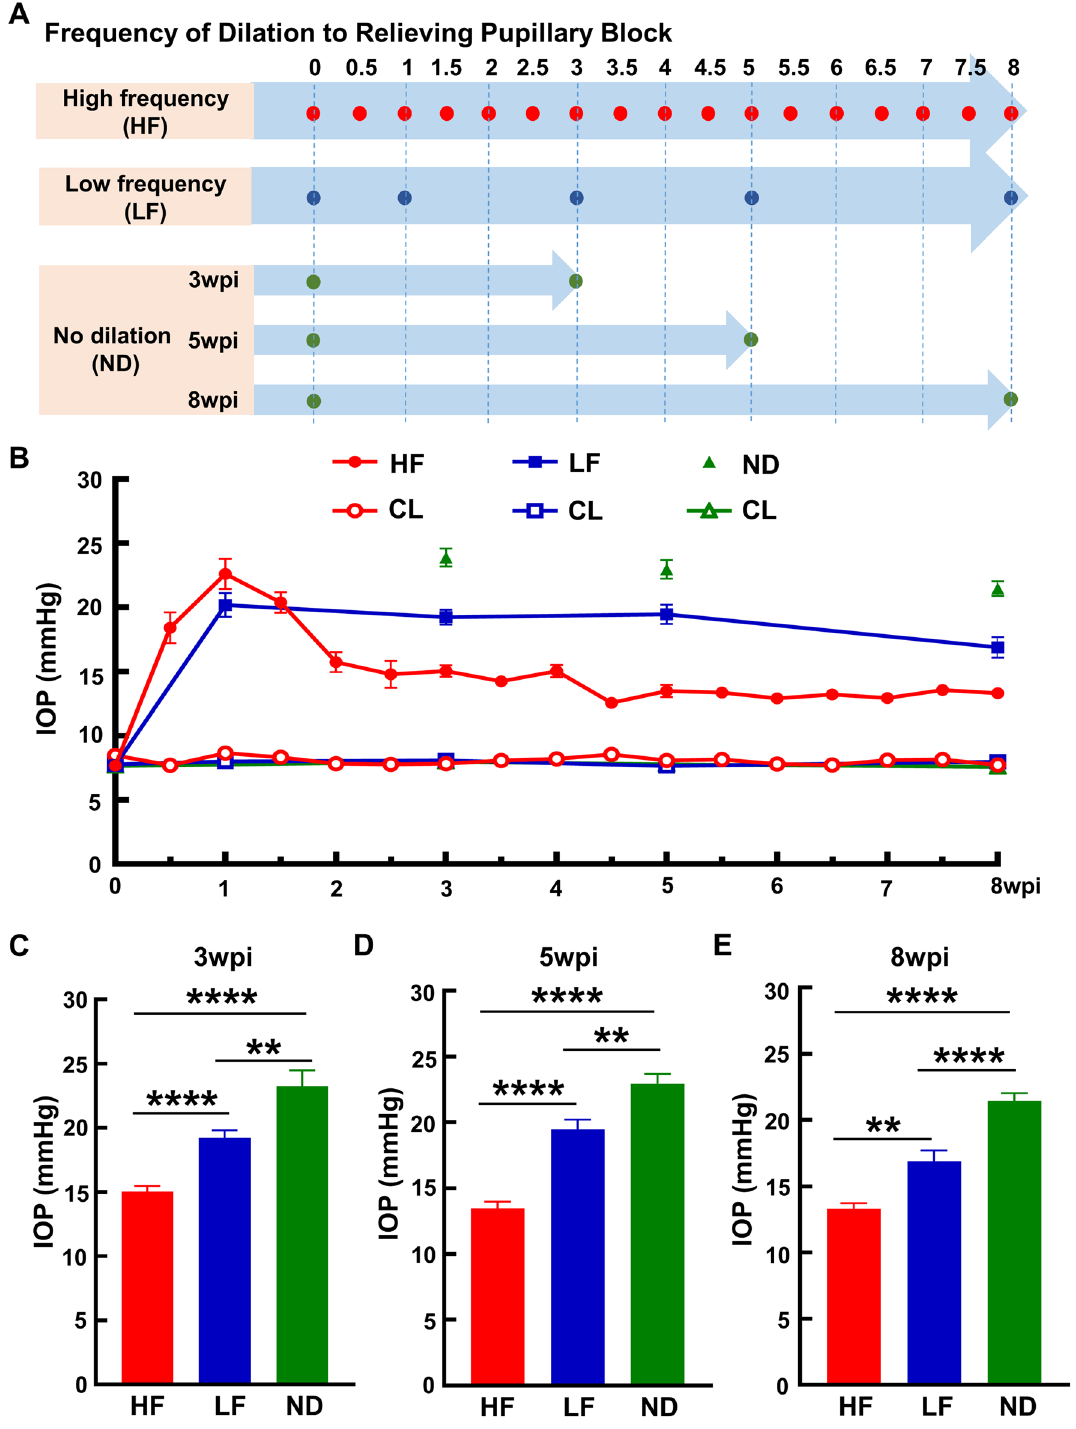
Figure 1. Low to high IOP elevations achieved by high to low frequencies of pupillary dilation after SO-induced ocular hypertension. ( A ) Schedule of dilation to relieve pupillary blocking after SO intracameral injection. HF: high frequency, twice a week; LF: low frequency, four times in eight weeks; ND: no dilation. wpi: weeks post SO injection. ( B ) Longitudinal IOP measurements of experimental eyes and contralateral control (CL) eyes at different time points after SO injection. ND groups at 3, 5 and 8wpi are independent groups that are sacrificed immediately after IOP measurement. ( C,D,E ) Comparisons of average IOP of the three groups at 3, 5 and 8wpi. Data are presented as means ± s.e.m, 3wpi: HF: n = 26, LF: n = 28, ND: n = 24; 5wpi: HF: n = 26, LF: n = 27, ND: n = 24; 8wpi: HF: n = 21, LF: n = 30, ND = 30. **: p < 0.01, ****: p < 0.0001, one-way ANOVA with Tukey’s multiple comparison